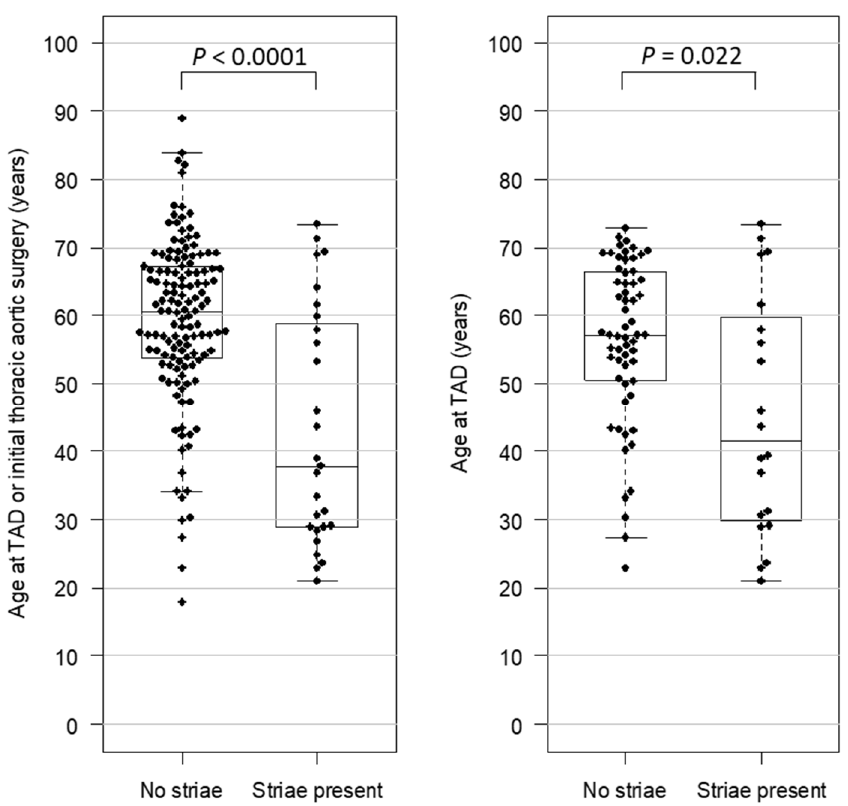
Figure 3. Comparison of age at clinical endpoints between cases with or without striae. Left graph